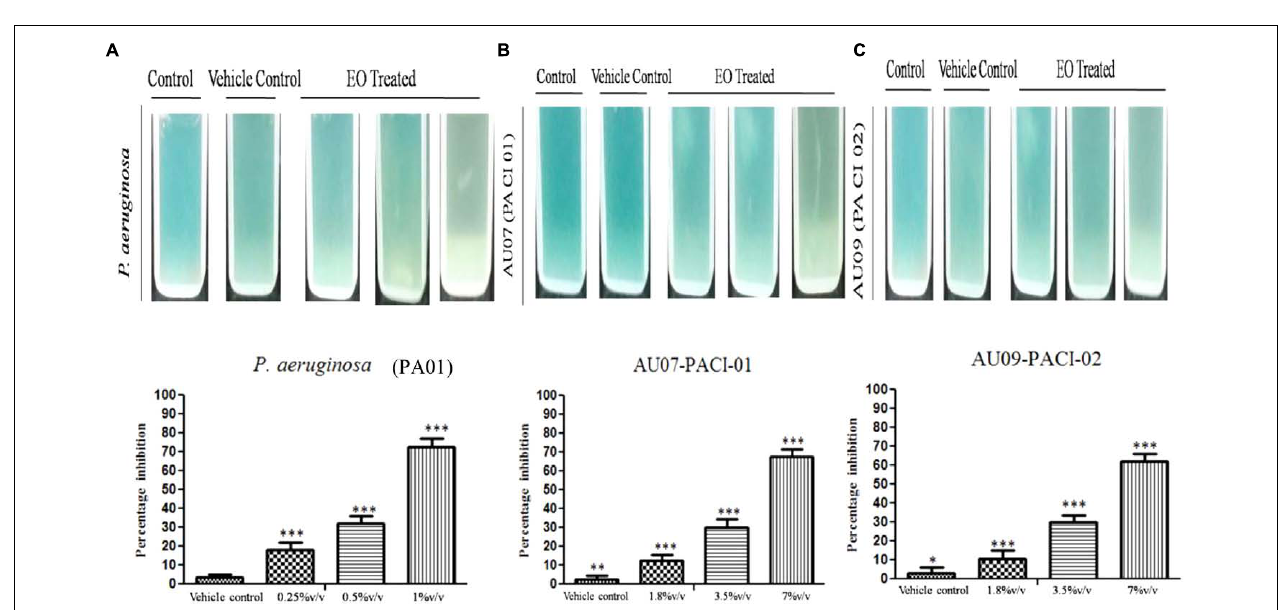
FIGURE 11 | Inhibition of pyocyanin (A) P. aeruginosa biofilm by EO treated (1–5% v/v), (B) AU07-PACI-01 biofilm in the presence of EO (1.8–7% v/v), (C) AU09-PACI-02 biofilm in the presence of EO (1.8–7% v/v). Mean values of triplicate independent experiments ± SD are shown. One-way ANOVA test demonstrates significant difference between the control and the test. Single asterisk indicates significant at P ≤ 0.025, double asterisk indicates significant at P ≤ 0.01, and triple asterisk indicates significant at P ≤ 0.005.